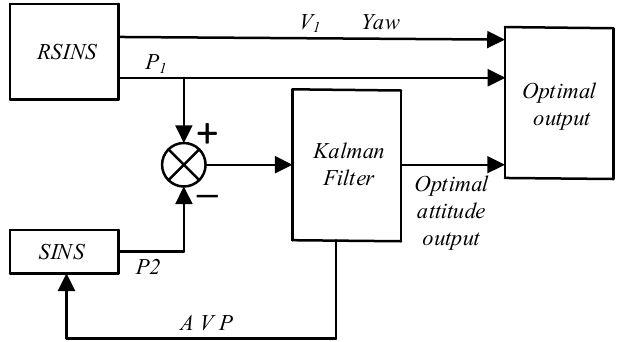
Figure 5. Dual inertial navigation combination scheme.